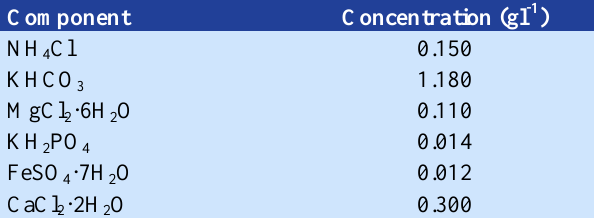
Table 2. Synthetic wastewater